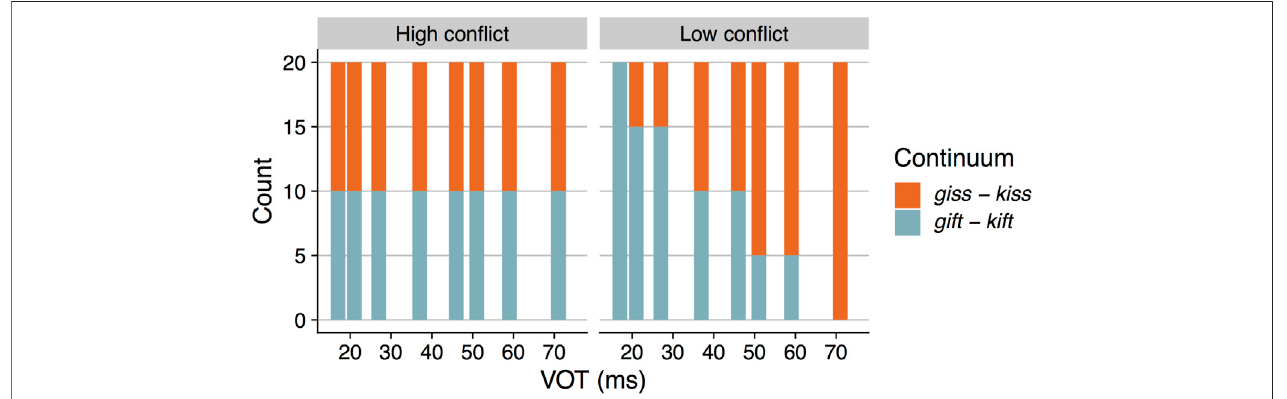
FIGURE 2 | Histograms showing input distributions (i.e., number of presentations of each VOT for each of the two continua contexts) for the high con fl ict and low con fl ict conditions.